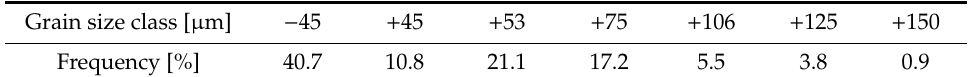
Table 2. Grain size distribution of AISI 316L powder.